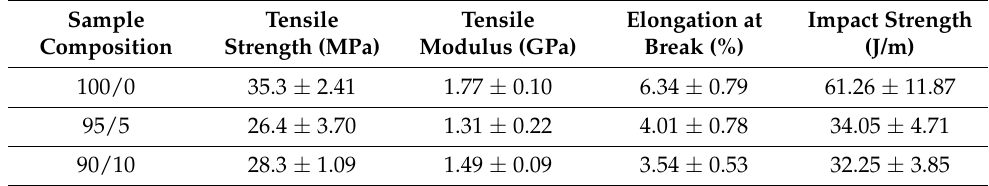
Table 1. Mechanical properties of FFF samples.